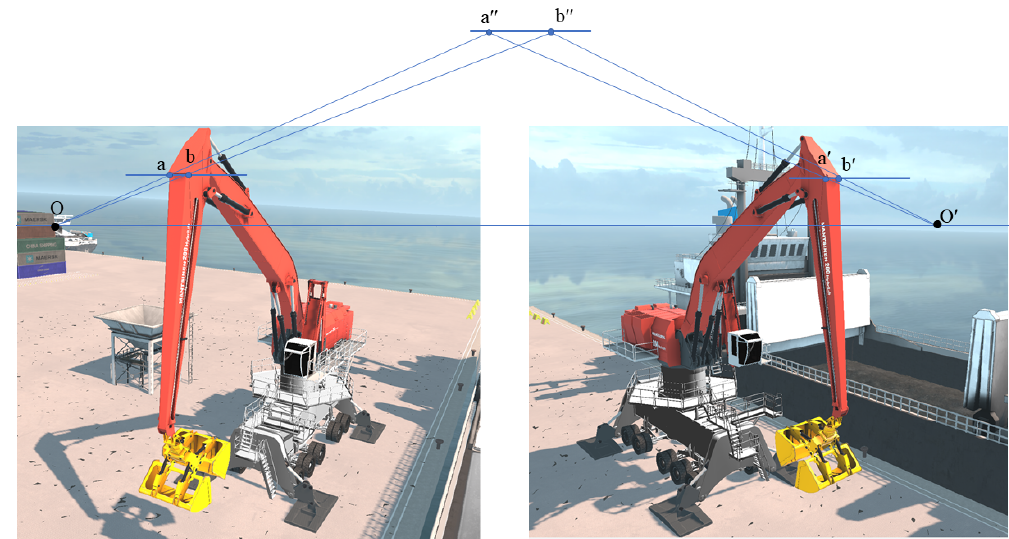
Figure 3. Estimation of three-dimensional specifications of a vehicle by comparing two planar images.